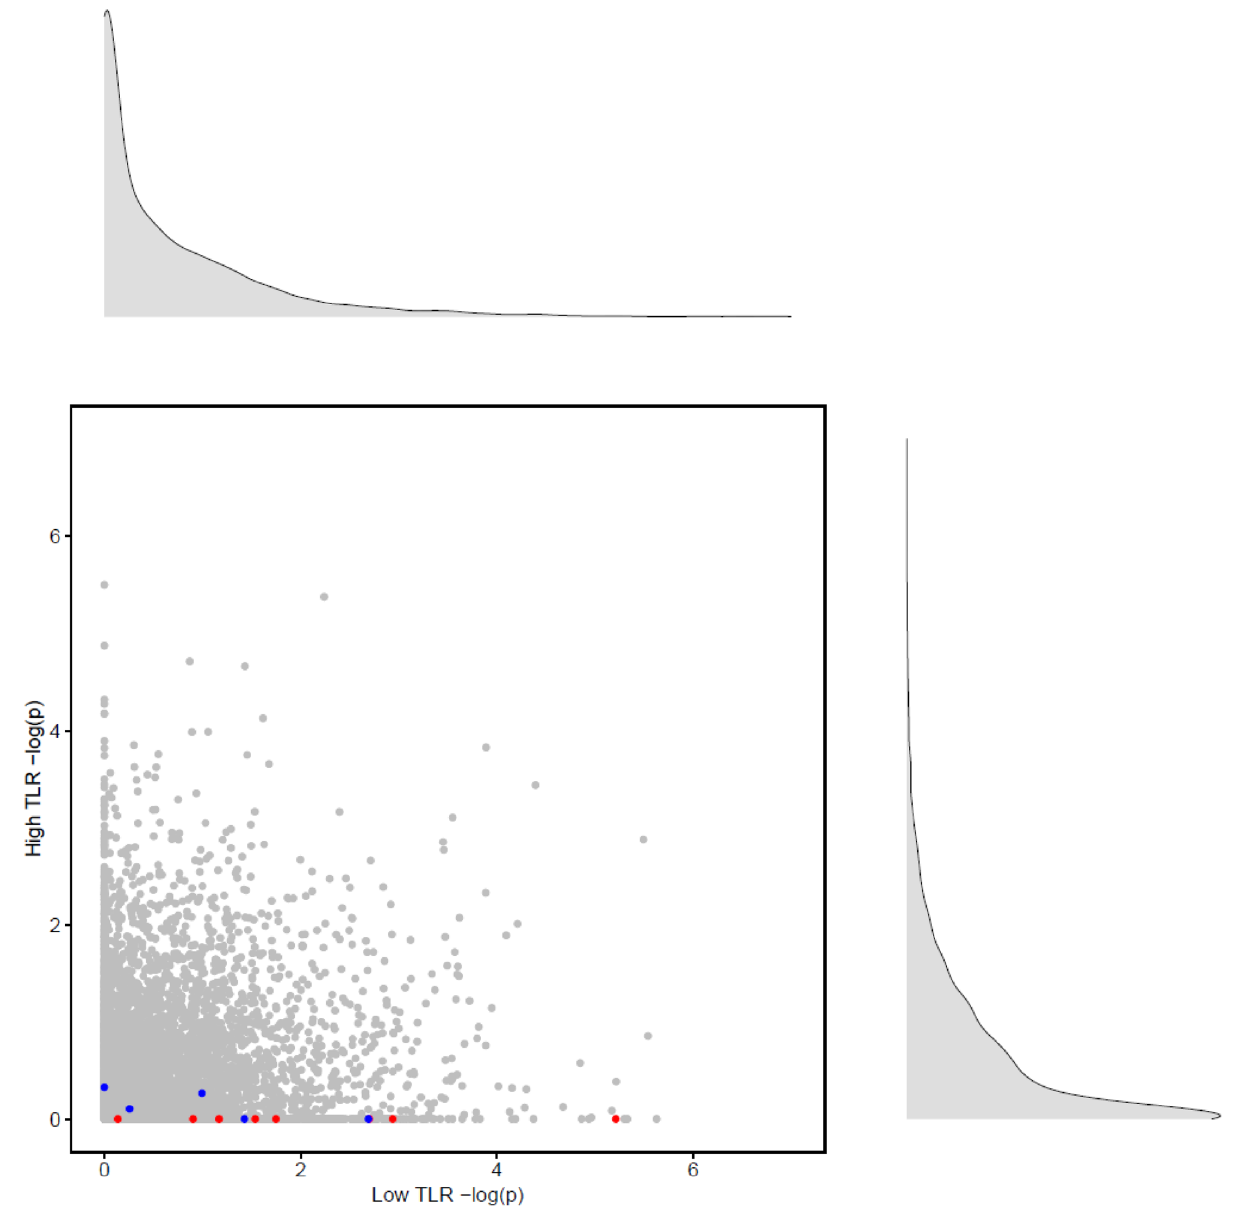
Figure 3. The pathway-level association (p-value) scatterplot for depressive symptoms in low versus high dietary TLR subgroups showing kynurenine-related pathways in blue, serotonin-related pathways in red, and p-values of biological process-related GO terms in grey on a negative base ten logarithmic scale (−